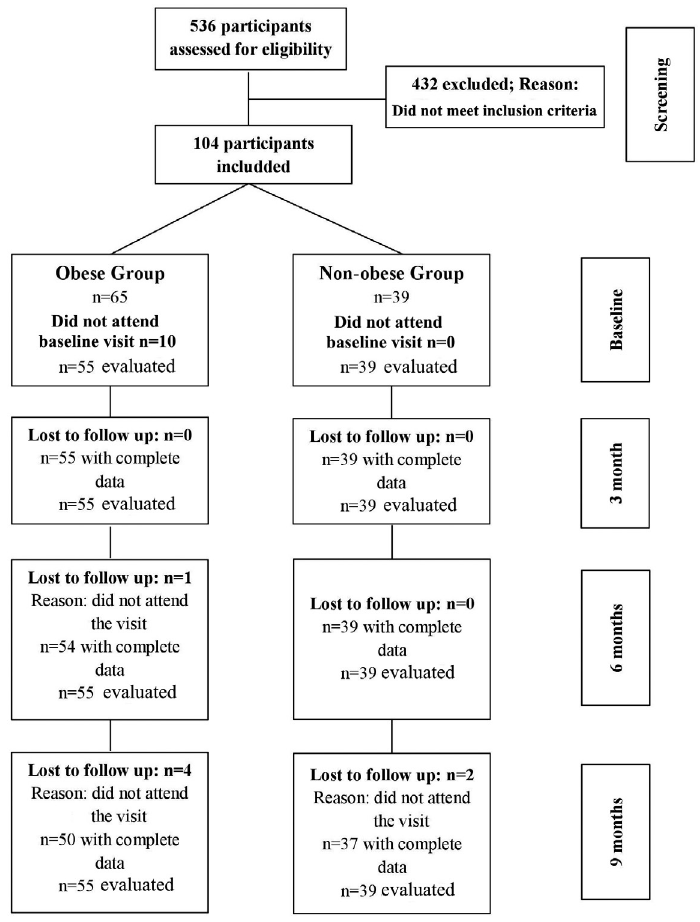
Figure 2- Flow chart of the study design